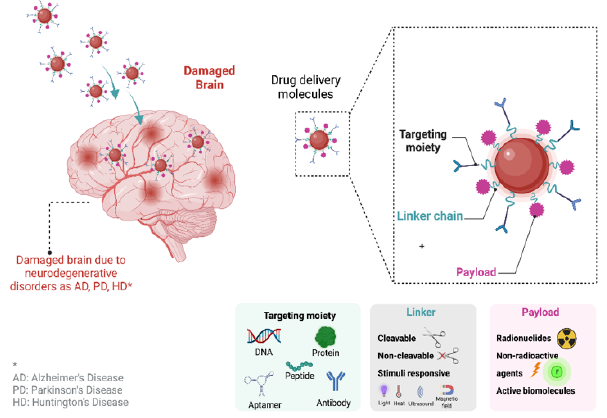
Figure 4. Various functionalized drug delivery systems have been employed to deliver active molecules to the brain, targeting neurodegenerative disorders. The modified nanoparticles carry targeting moieties, i.e., DNA, antibodies, peptides, aptamers, and proteins, and are able to encapsulate radionuclides, non-radioactive agents, as well as active molecules. In addition, the multifunctional carriers incorporate linkers so as to improve stability, higher payload, and stimuli responsive behavior (created with BioRender.com).